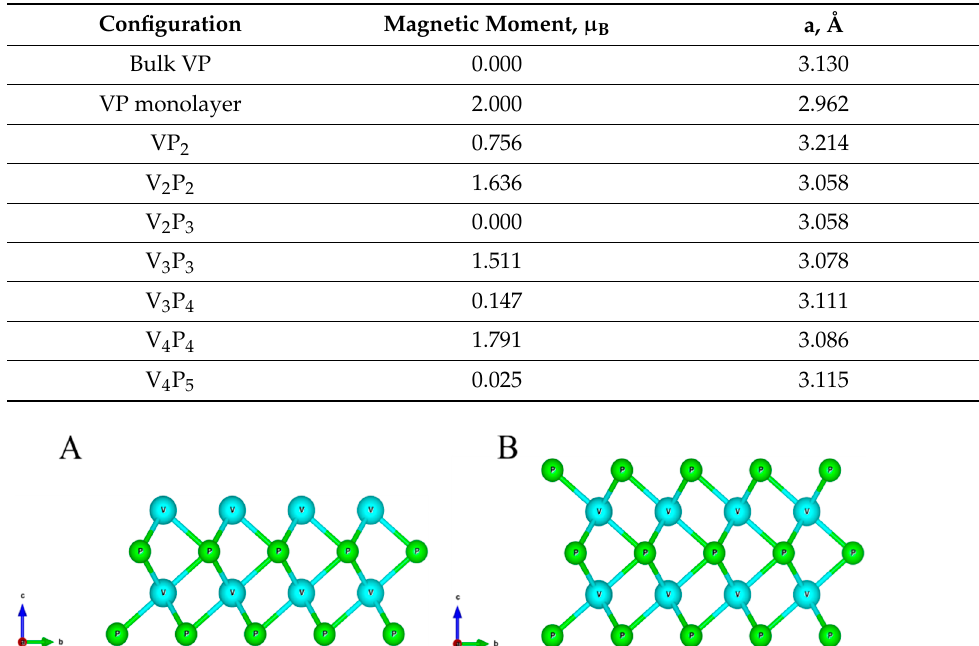
Figure 1. Atomic structure of VP thin films. ( A ) stoichiometric (V 2 P 2 ) and ( B ) non-stoichiometric (V 2 P 3 ) VP bilayer. (V 2 P 3 ) VP Table 1. Lattice parameter a, magnetic moment and stability of stoichiometric and non-stoichiometric configurations of VP from one to four layers.